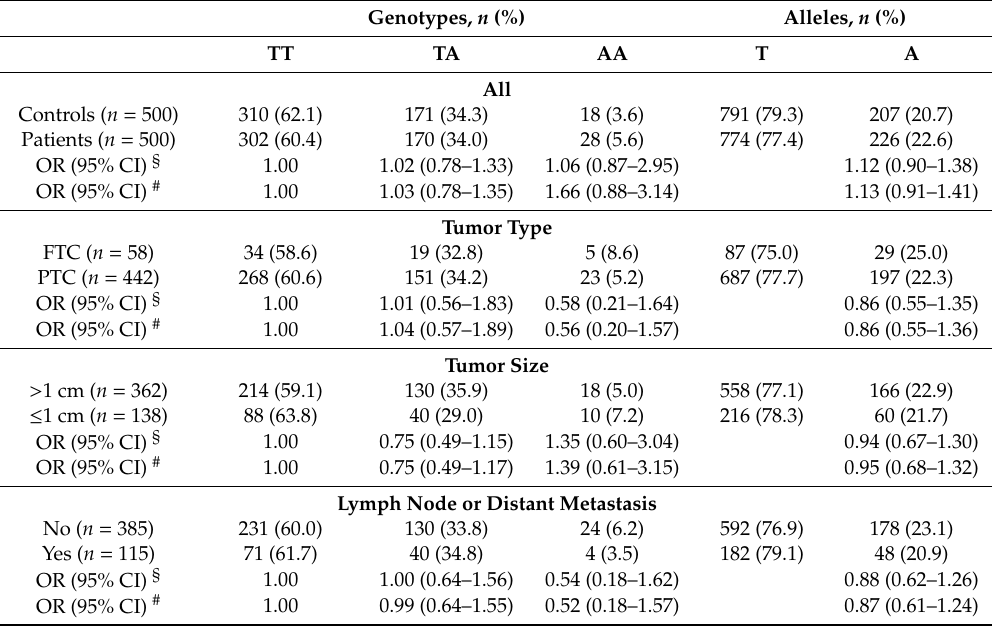
Table 3. Analysis of CYP24A1 rs6013897 genotype and allele